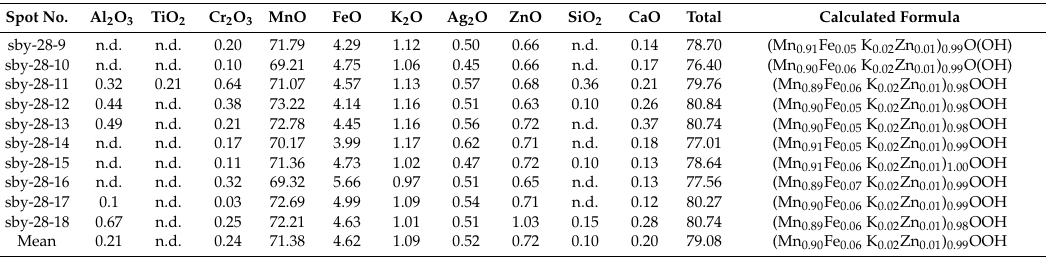
Table 2. Electron probe X-ray microanalysis (wt.%) of acicular manganite from the Sanbao